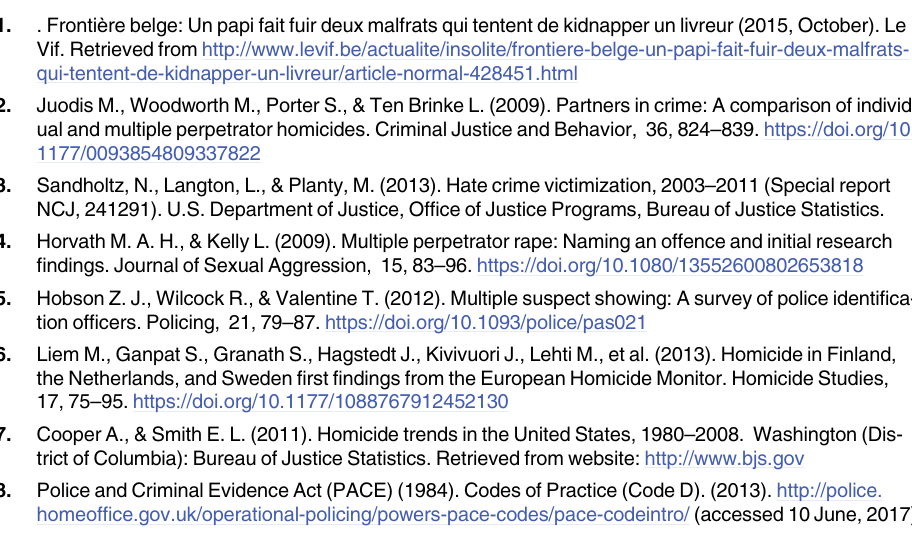
S3 Table. Experiment 3: Choosing rates (standard error) given previous choosing as a func- tion of stimulus